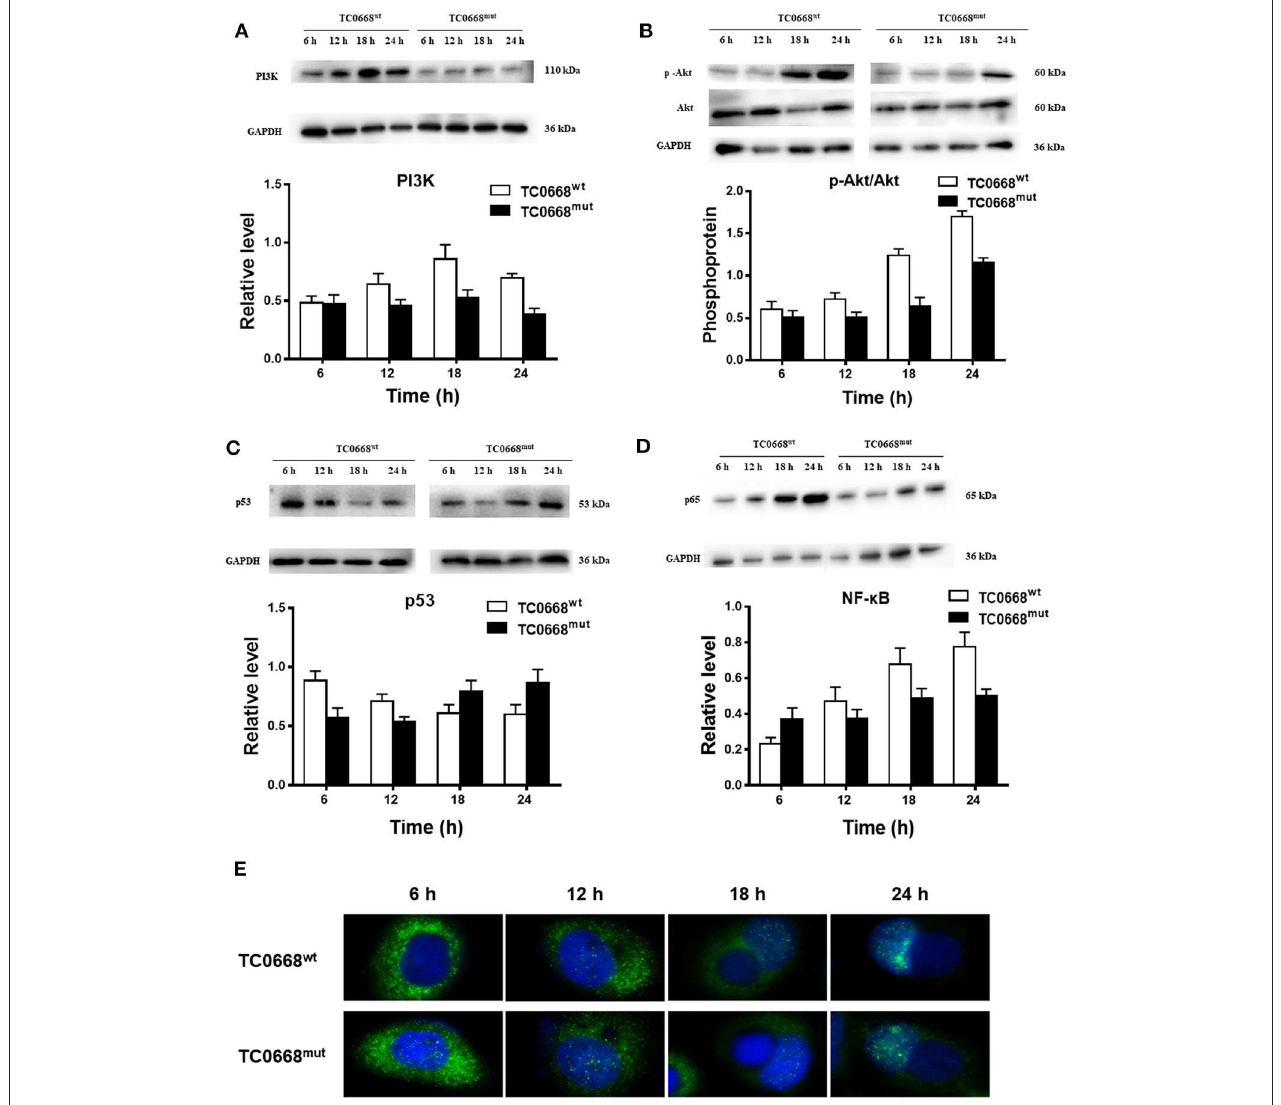
FIGURE 7 | Activation of NF- κ B and PI3K/Akt signal pathways as determined using western blotting and IFA. With 1 × 10 6 IFUs/well inoculum (six-well plate) or 2.5 × 10 5 IFUs/well inoculum (24-well plate), expression of PI3K, p-Akt, p53, and NF- κ B (p65) representing activation of PI3K/Akt and NF- κ B signal pathways were determined using western blotting or IFA, respectively. Gel quantification software was used to calculate the relative intensity of the corresponding signals. The relative value (target protein/GAPDH) differences of PI3K, p53, and NF- κ B (p65) molecules and the relative expression level of p-Akt (p-Akt/Akt) between TC0668 wt - and TC0668 mut -infected cells were statistically significant (one-way ANOVA, P < 0.05). (A) Expression of PI3K molecules in TC0668 mut - and TC0668 wt -infected cells were determined using western blotting at 6, 12, 18, and 24h post-infection. (B) Expression of p-Akt and total Akt in TC0668 mut - and TC0668 wt -infected cells were determined using western blotting at 6, 12, 18, and 24h post-infection. (C) Expression of p53 molecules in the TC0668 mut - and TC0668 wt -infected cells at 6, 12, 18, and 24h post-infection. (D) Expression of p65 molecules in the TC0668 mut - and TC0668 wt -infected cells at 6, 12, 18, and 24h post-infection. (E) NF- κ B molecules in the cytoplasm and nuclei of TC0668 mut - and TC0668 wt -infected HeLa cells at 6, 12, 18, and 24h post-infection. DAPI dye core (blue), NF- κ B fluorescence secondary antibody is 488 dye